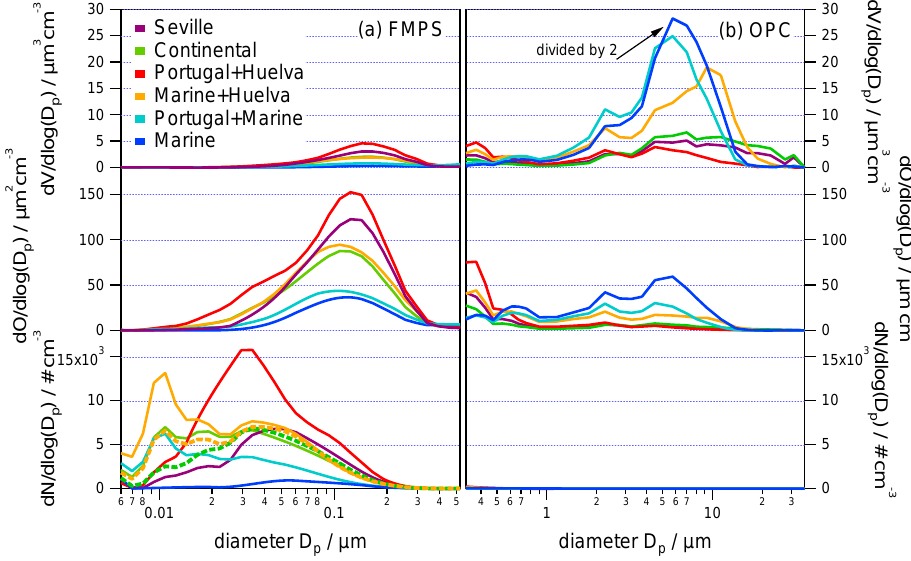
Fig. 7. Averaged particle size distributions in the size range of 7nm until 32µm for all air mass types using the FMPS (a) and OPC (b) data. The FMPS registers particle diameters in a size range of 7–523nm ( D mob ) while the OPC covers the particle size range 320nm until 32µm ( D opt ) . Dotted lines in the number distribution show averaged concentrations without considering new particle formation events for the “Marine+Huelva” and the “Continental” categories. The observed discrepancies could be due to the fact that both instruments base on different measurement methods and both reach their limits regarding the smallest and largest